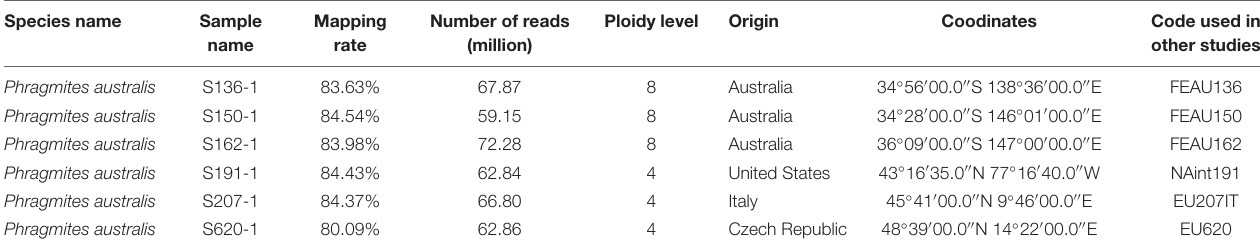
TABLE 1 | Sample information of the RNA-seq data used in this